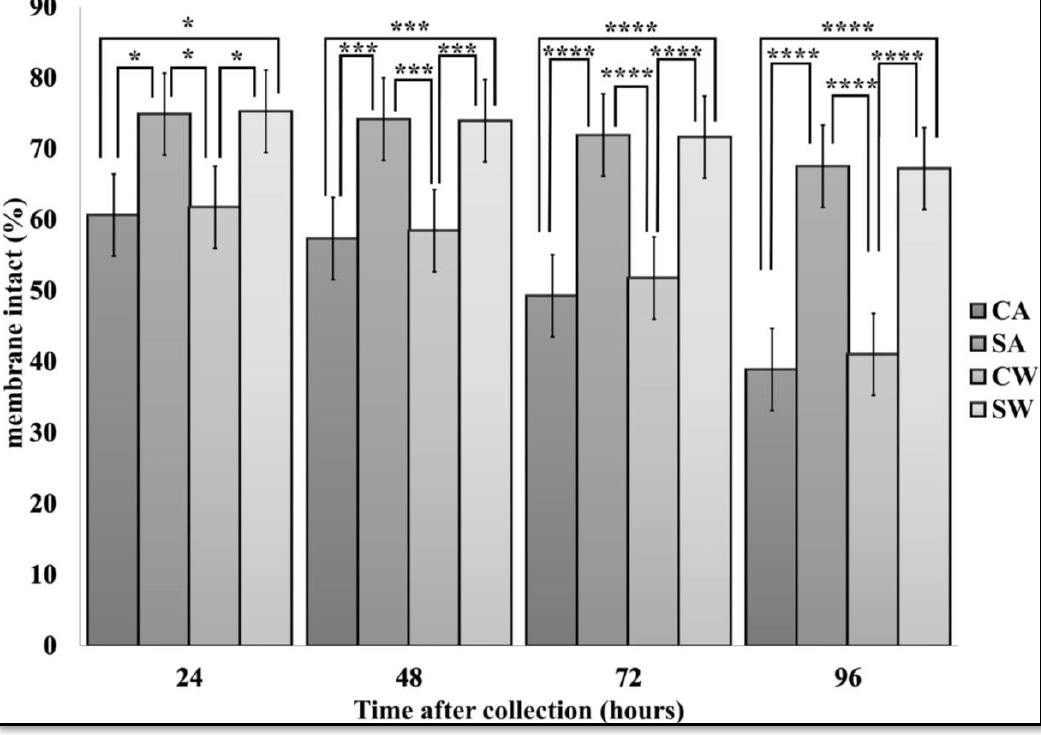
Figure 3. Membrane integrity in control and MSLC samples, with and without antibiotics, during storage for 96 h at 6 °C. Values are Least Squares Means ± SE ( n = 18). Note: * P < 0.05, *** P < 0.001, **** P < 0.0001; not possible to analyze samples at 0 h. Abbreviations: CA, control with antibiotics; SA,